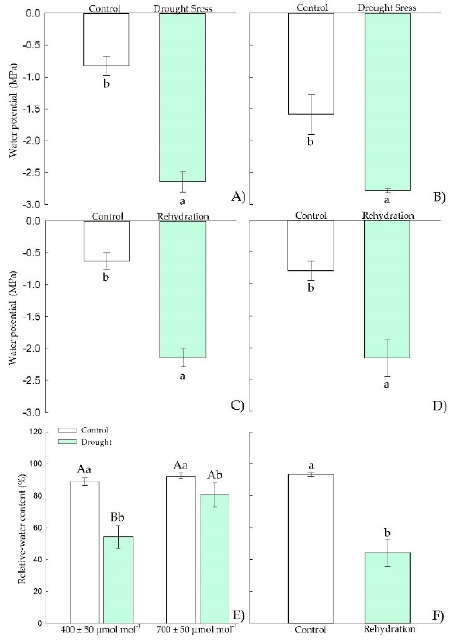
Figure 7. Effects of CO 2 concentration ( a [CO 2 ] = 400 µ mol mol − 1 and e [CO 2 ] = 700 µ mol mol − 1 ) and drought stress in A. buniifolius leaf in water potential predawn ( A , C ); water potential after midday ( B , D ), relative water content ( E , F ). In plants sampled after drought stress ( A , B , E ) and rehydration ( C , D , F ) period. Different uppercase letters indicate a significant difference between values in different CO 2 within the same water treatment, while different lowercase letters indicate significant differences between values of different water treatments within each CO 2 level by Tukey’s test ( p ≤ 0.05). ns denotes non-significance ( p > 0.05). Error bars represent a 95% confidence